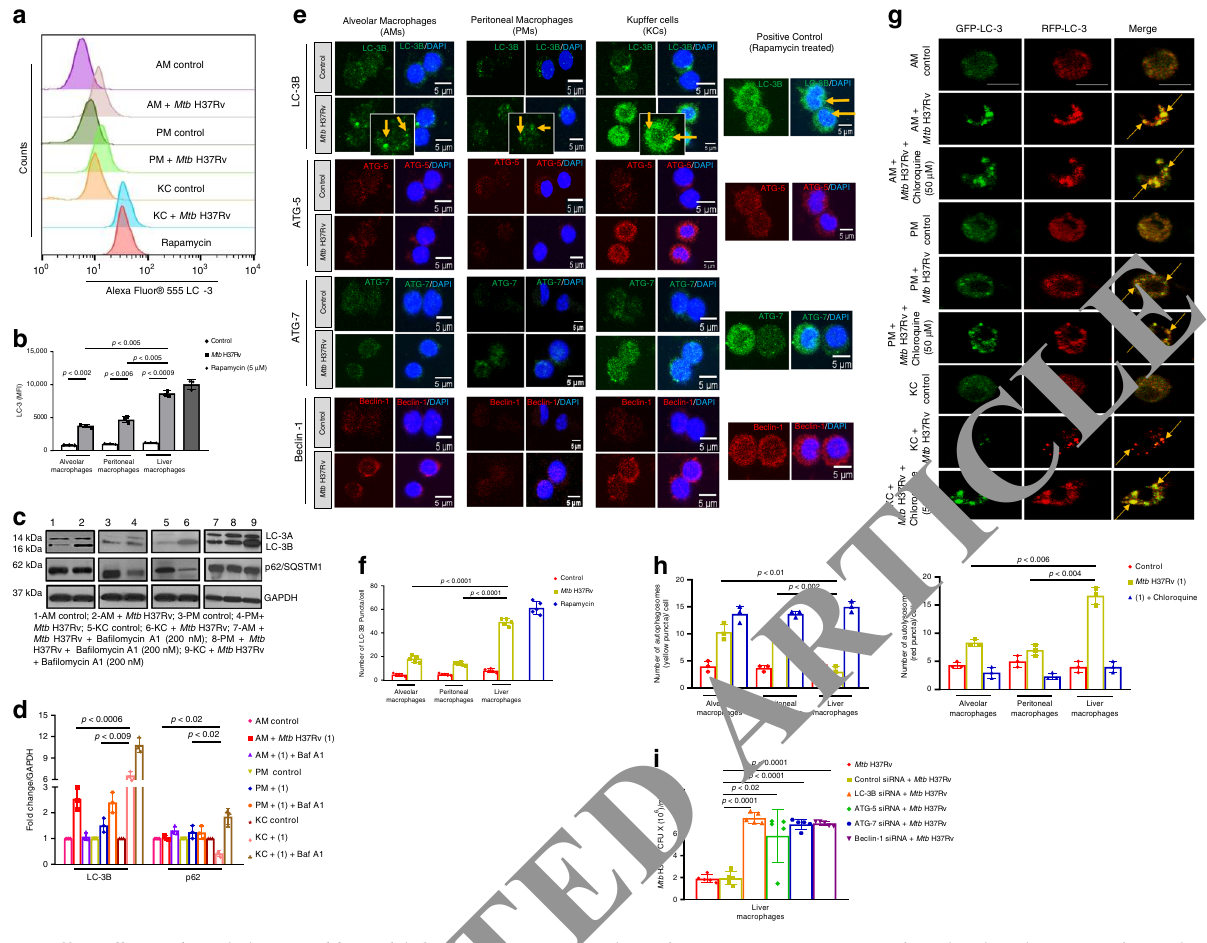
Fig. 3 Kupffer cell autophagy is increased by Mtb infection. AMs, PMs, and KCs from C57BL/6 mice were infected with Mtb H37Rv. After 72 h, LC-3 positive cells were evaluated by fl ow cytometry. a Representative fl ow cytometry plot for LC-3. b Mean fl uorescence intensity (MFI) of LC-3 expression. n = 3 experiments. p < 0.0024, p < 0.0064, p < 0.0051, p < 0.0058. c Total protein was extracted from the above cells and western blotting was performed. A representative blot depicting the levels of LC-3 and p62/SQSTM1 in the control, Mtb H37Rv-infected and ba fi lomycin A1 treated macrophages is shown. GAPDH was used as a loading control. d Normalized fold intensities of LC-3B, p62 levels in Mtb H37Rv-infected macrophages relative to the levels in the uninfected control. n = 3 experiments. p < 0.0098, p < 0.0263, p < 0.028. e A representative micrograph of LC3-B, ATG-7, ATG- 5 and Beclin-1 in AMs and KCs. Blue: DAPI; green: LC-3B and ATG-7; red: ATG-5 and Beclin-1. Images of multiple fi elds were taken at 63× magni fi cation with oil immersion. f The number of LC-3B puncta relative to the cell area was measured using ImageJ and quanti fi ed in 10 cells per condition. g Macrophages were labeled with an autophagy sensor expressing RFP-GFP-LC3B for 48 h. The labeled macrophages were then infected with Mtb H37Rv for 72 h. The cells were fi xed, and LC-3B was analyzed by confocal microscopy. Autophagosomes show both GFP (green) and RFP (red) signals. Autophagosome-lysosome fusion results in RFP-positive and GFP-negative dots. Scale bars: 5 µ m. h Quanti fi cation of the number of LC-3B positive autophagosomes (yellow fl uorescence) and autolysosomes (red fl uorescence) in control, Mtb -infected macrophages followed by treatment with or without chloroquine is shown. n = 3 experiments. p < 0.0142, p < 0.0025, p < 0.0063, p < 0.0047. i KCs from C57BL/6 mice were isolated and transfected with siRNAs targeting LC-3B, ATG-5, ATG-7 and Beclin-1 or with control siRNA and then infected with Mtb H37Rv. After 5 days, CFUs were counted. n = 5 experiments. Data are presented as the mean ± SD using paired two-tailed t